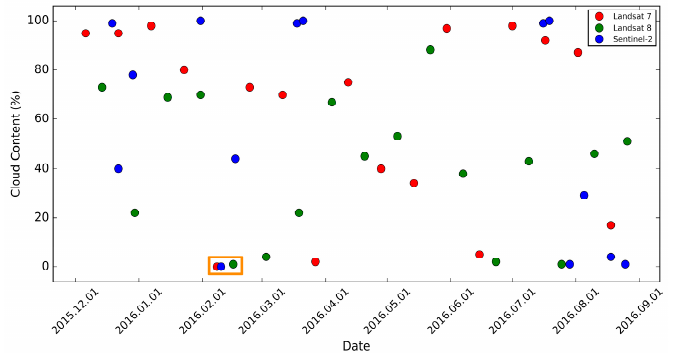
Figure 2. Data availability and cloud contents of Landsat 7 ETM+, Landsat 8 OLI, and Sentinel-2 MSI images from December 2015 to September 2016. The selection of the compared group considered the temporal adjacency among them and cloud effects.